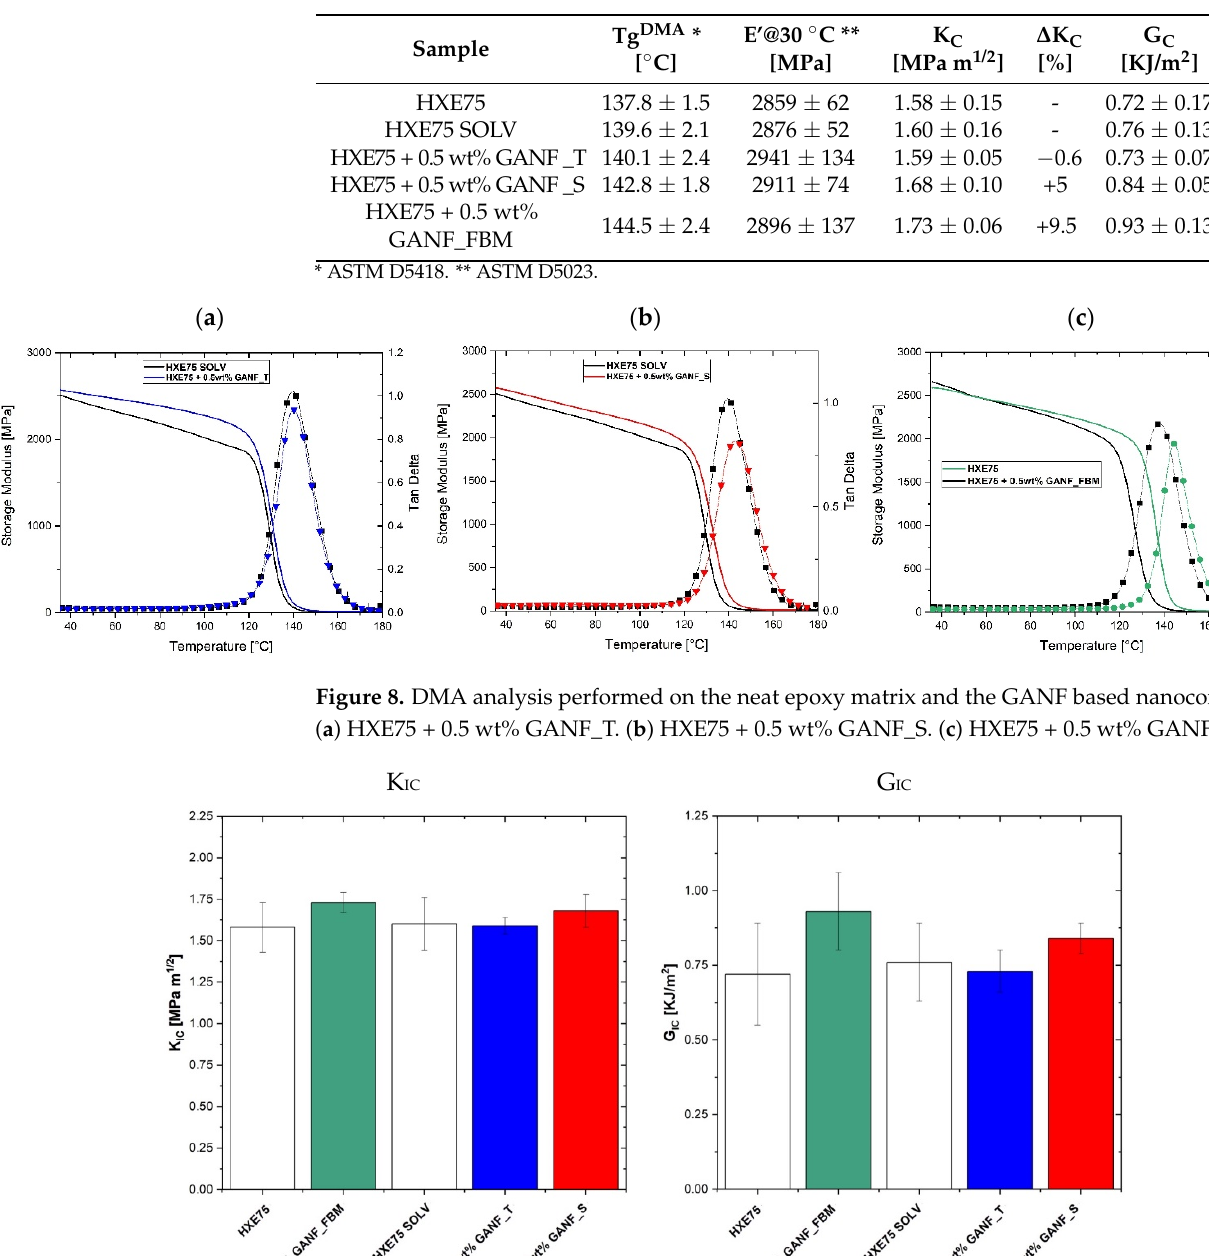
Table 5. Results of the mechanical characterization (DMA and fracture toughness) of the GANF based nanocomposites.